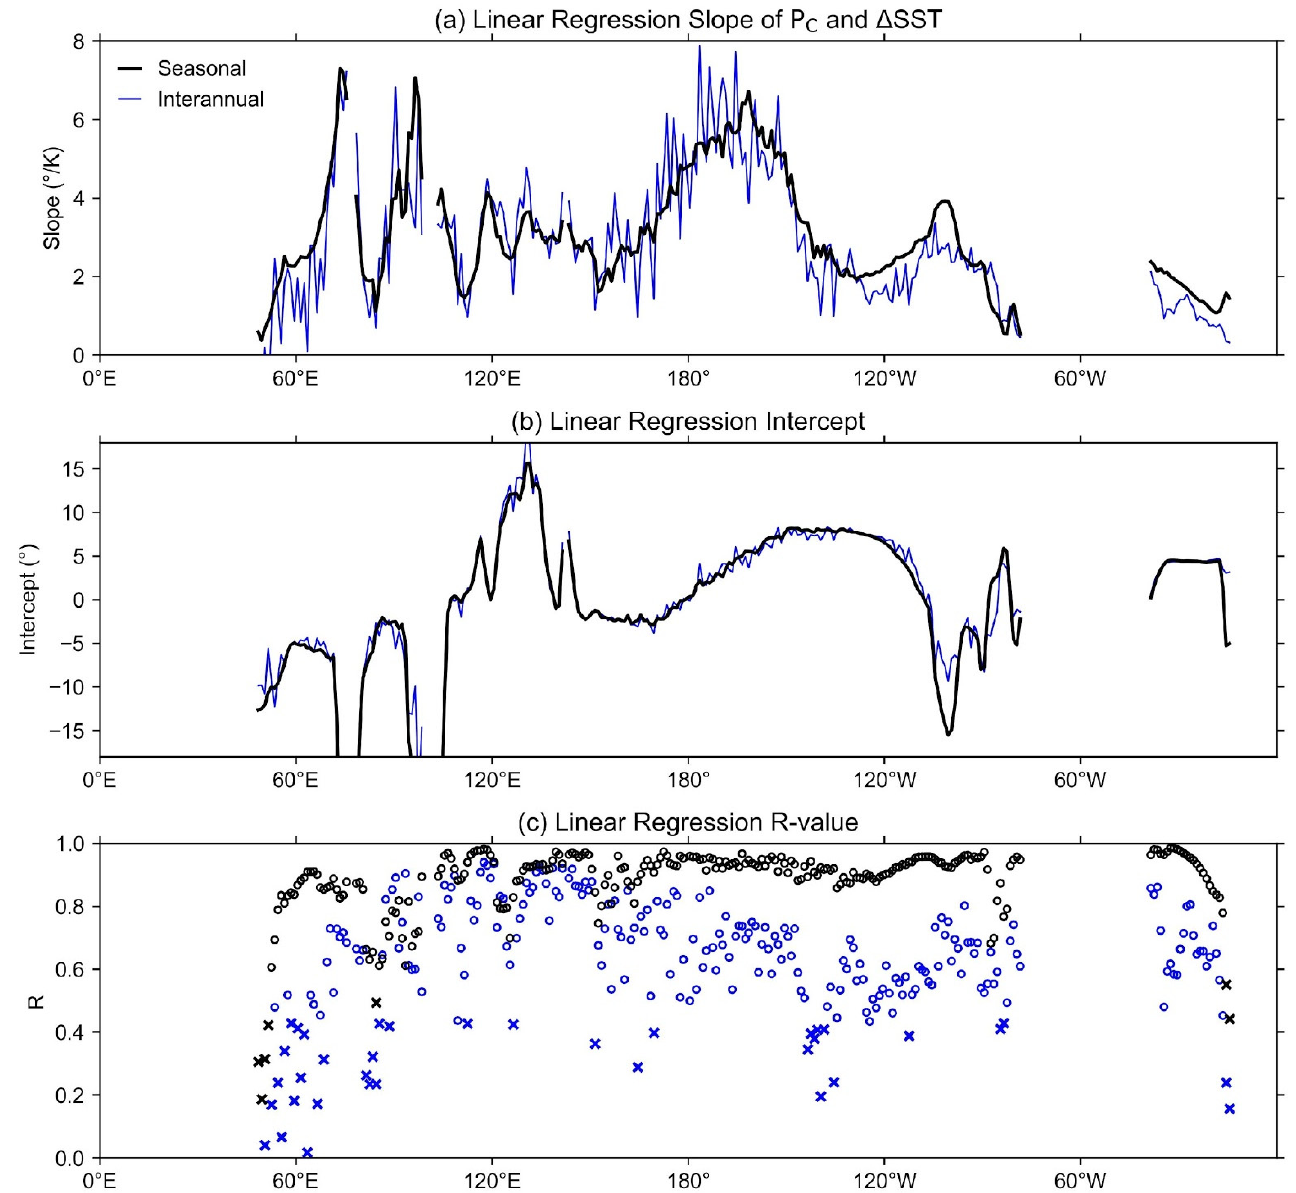
Figure 3. Observed relationship between the local ITCZ position and interhemispheric SST contrast at each longitude, over seasonal (black) and interannual (blue) timescales. The slope ( a ) and intercept ( b ) of the best-fit line, and the R-value ( c ) of the linear regression, are shown. In ( c ) open circles are statistically significant; crosses are not. The interannual correlation of the ITCZ position and SST contrast is generally weaker than the seasonal correlation but is still overwhelmingly significant.